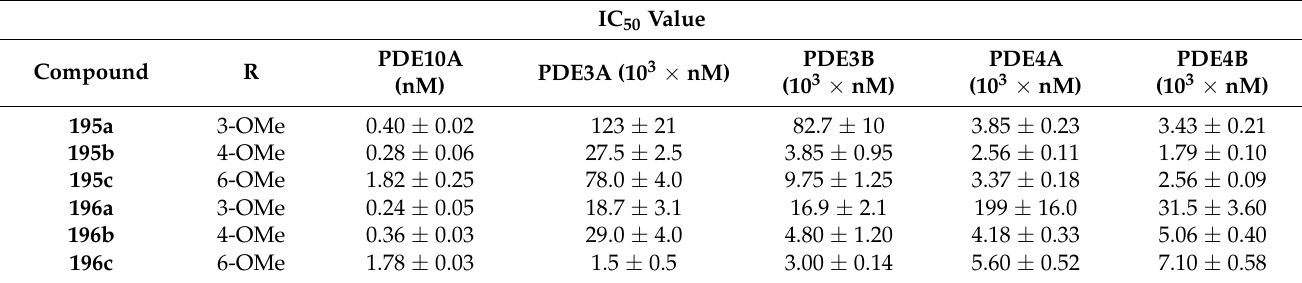
Table 3. PDE affinities of new MP-10 analogues.